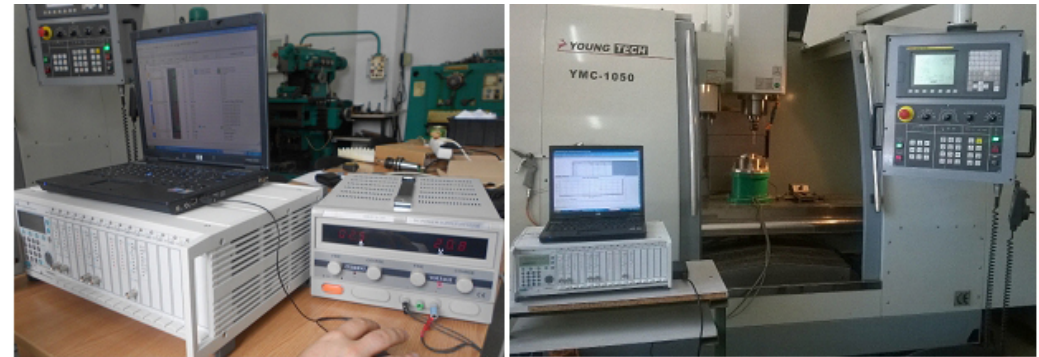
Figure 12. MGCplus measurement system for deformations manufactured by HBM.